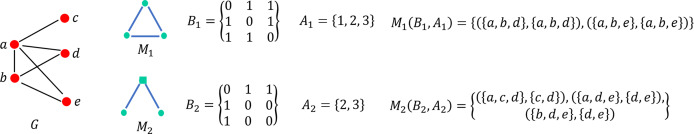
Example of motif definition in diagram: the motifs Tri1 and Tri2 are leveraged to detect in the five-node graph G on the left figure.The motifs are defined by a binary matrix B and an anchor set of nodes. B1 and B2 are the binary matrices of Tri1 and Tri2, respectively. Similarly, A1 and A2 are the anchor node sets of Tri1 and Tri2, respectively.